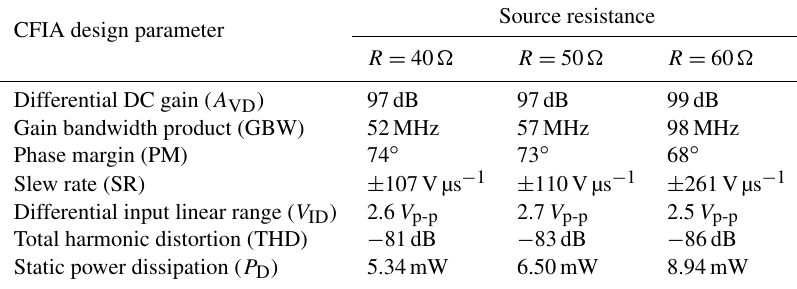
Table 6. Optimized CFIA characteristics results with non-ideal sinusoidal voltage source, V DD = 3 . 3V, V CM = 1 .